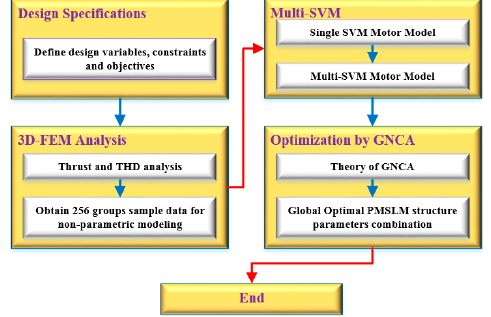
Figure 6. Flowchart of the proposed optimization method.